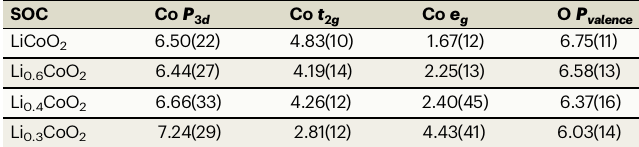
Table 2 | Co 3d -orbital populations and the number of valence electrons of oxygen obtained from the multipole